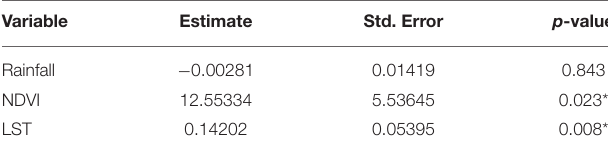
TABLE 1 | Regression results of female adult vector populations and rainfall, normalized difference vegetation index (NDVI), and land surface temperature